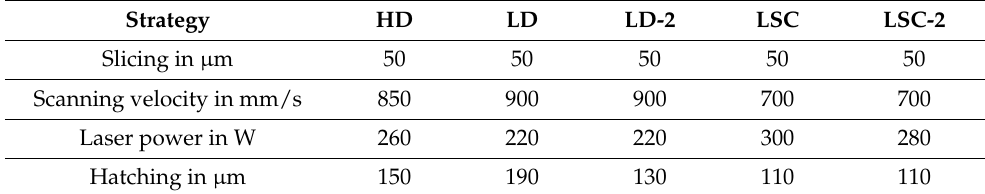
Table 1. Parameters conducted for processing via